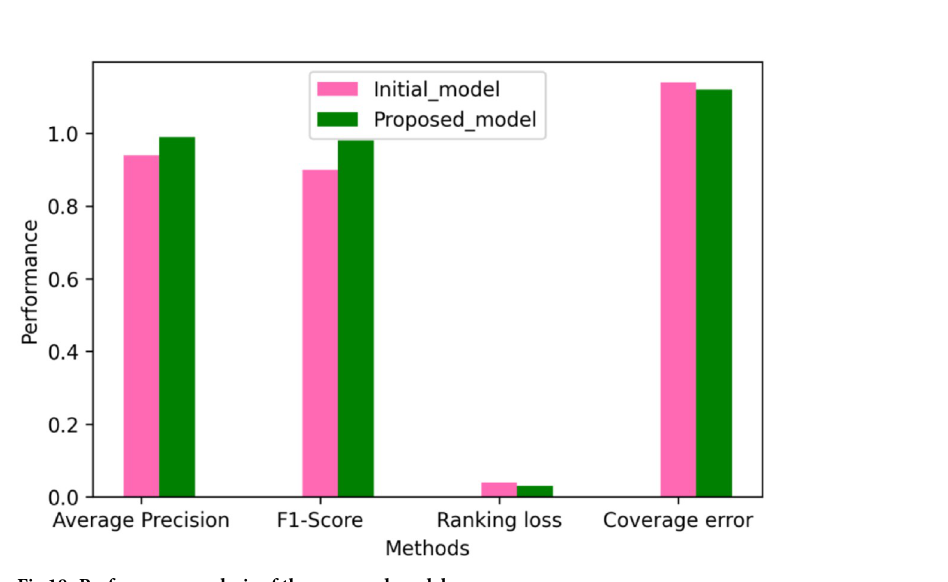
Fig 18. Performance analysis of the proposed model.